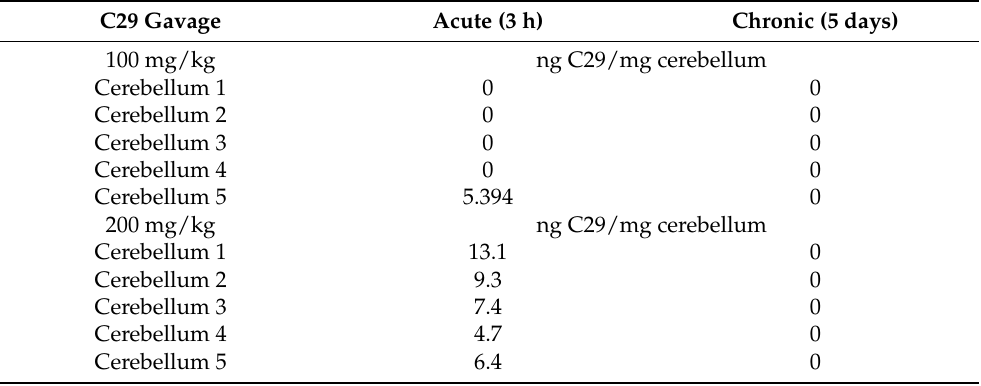
Table 3. C29 crosses the blood–brain barrier. The table shows the amounts of C29 (ng/mg cerebellum) that passed the blood–brain barrier in 10 cerebellar mice previously treated with 100 mg/kg and 10 others treated with 200 mg/kg. In each group, 5 mice were trafficked once, and their cerebellum was recovered after 3 h. Five mice were treated daily for 5 days (their cerebellum was recovered 24 h after the last treatment). C29 was determined by HPLC. C29 Gavage Acute (3 h) Chronic (5 days) 100 mg/kg ng C29/mg cerebellum Cerebellum 1